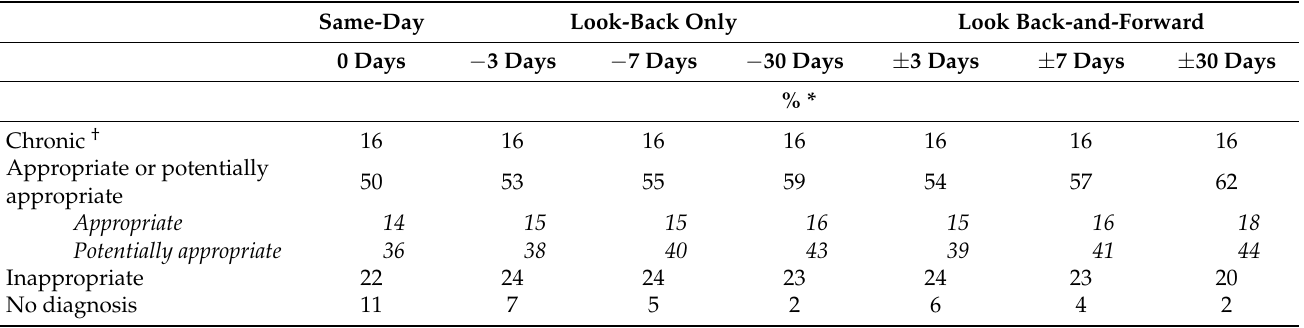
Table 1. Different Look-Back and Look-Back-and-Forward Durations and the Apparent Appropriate- ness of Antibiotic Prescribing ( n = 714,057 antibiotic